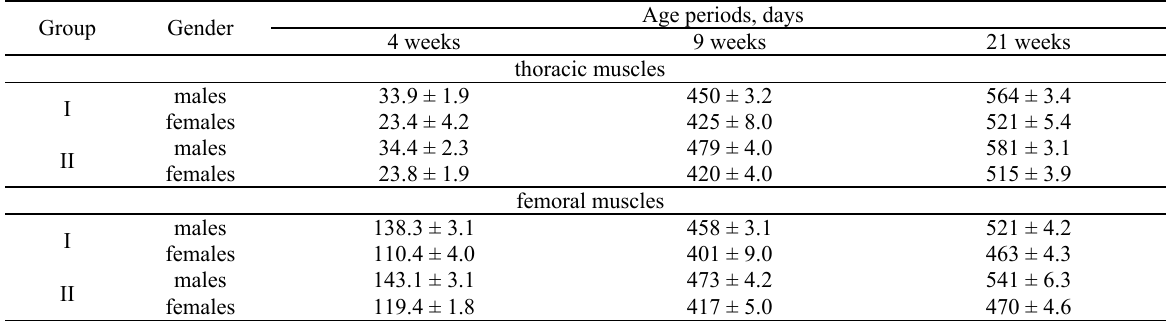
Development of thoracic and femoral muscles in geese with periods of development, gr.